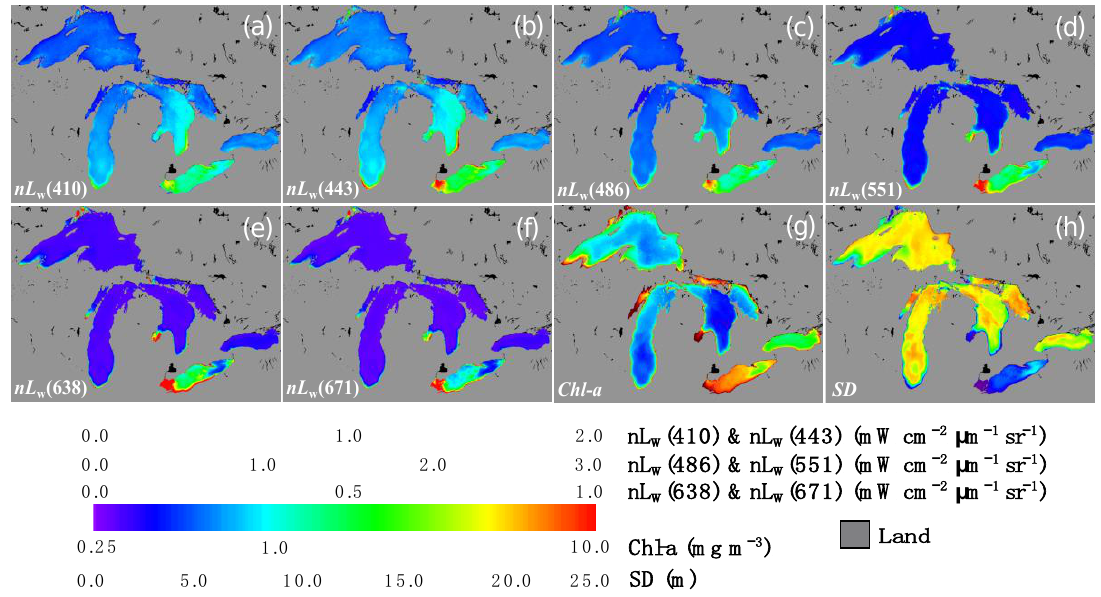
Figure 10. VIIRS-SNPP-derived climatology (2012–2019) images of ( a ) nL w (410), ( b ) nL w (443), ( c ) nL w (486), ( d ) nL w (551), ( e ) nL w (638), ( f ) nL w (671), ( g ) Chl-a, and ( h ) SD in the Great Lakes.